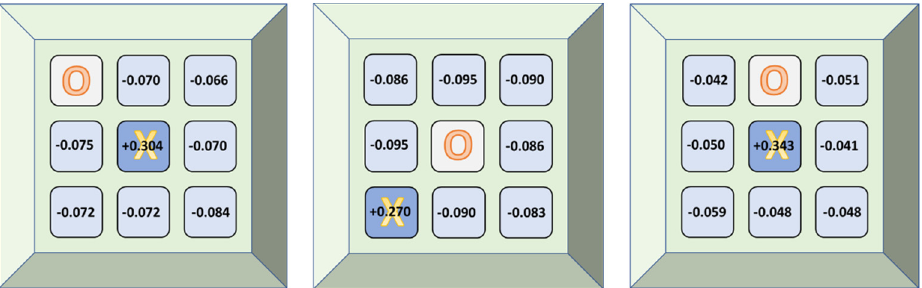
Figure 3. Estimated utilities by the tic-tac-toe TD agent (X-player) for all reachable states in 3 different games, given 3 distinct initial positions occupied by the opponent (O-player).